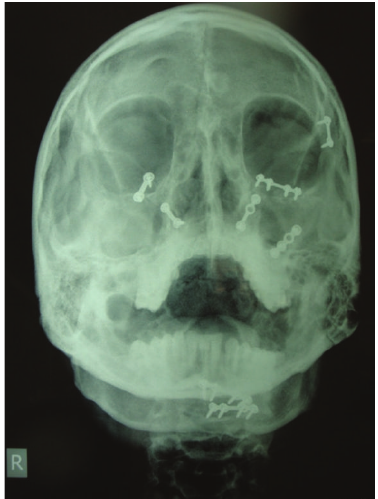
Figure 3: Postoperative paranasal sinus view after 1 year.